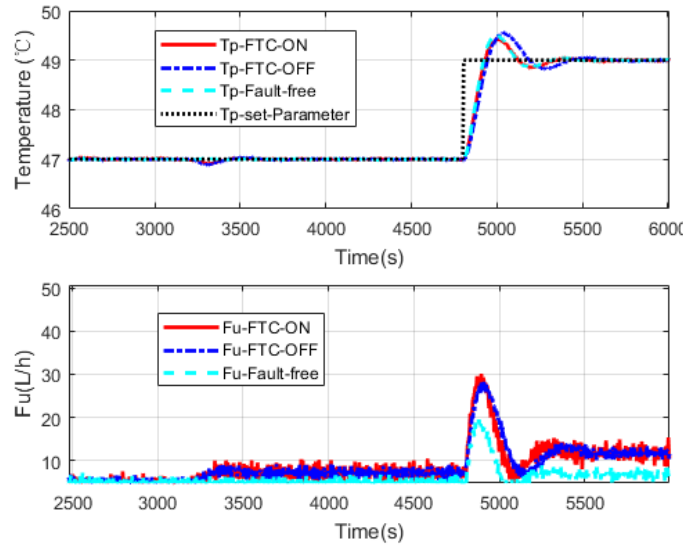
Figure 14. FTC simulation of T uin